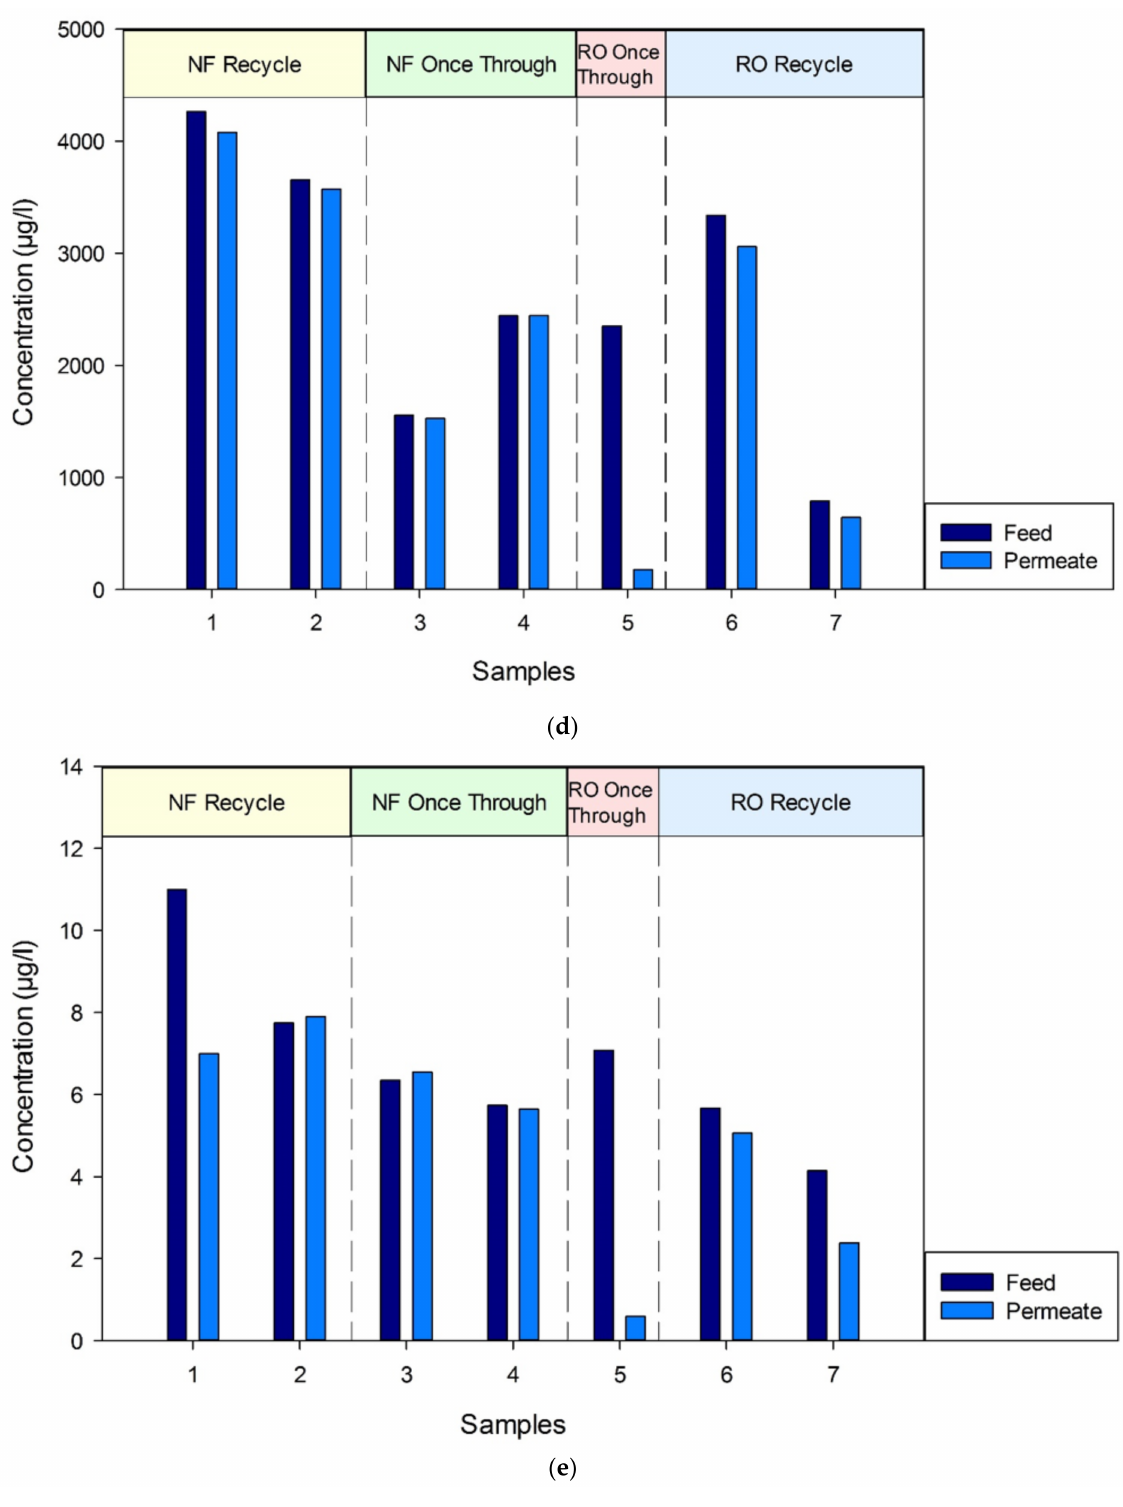
Figure 6. ( a ) Graphical representation of GC–MS data for vinyl chloride throughout the pilot trial. ( b ) Graphical repre- sentation of GC–MS data for cis-1,2-dichlorothylene throughout the pilot trial. ( c ) Graphical representation of GC–MS data for 2,2-dichloropropane throughout the pilot trial. ( d ) Graphical representation of GC–MS data for trichloroethylene throughout the pilot trial. ( e ) Graphical representation of GC–MS data for tetrachloroethylene throughout the pilot trial. For both operating configurations, the GC–MS method for VOCs detected very little or no separation occurring during the NF trial, with the feed and permeate samples